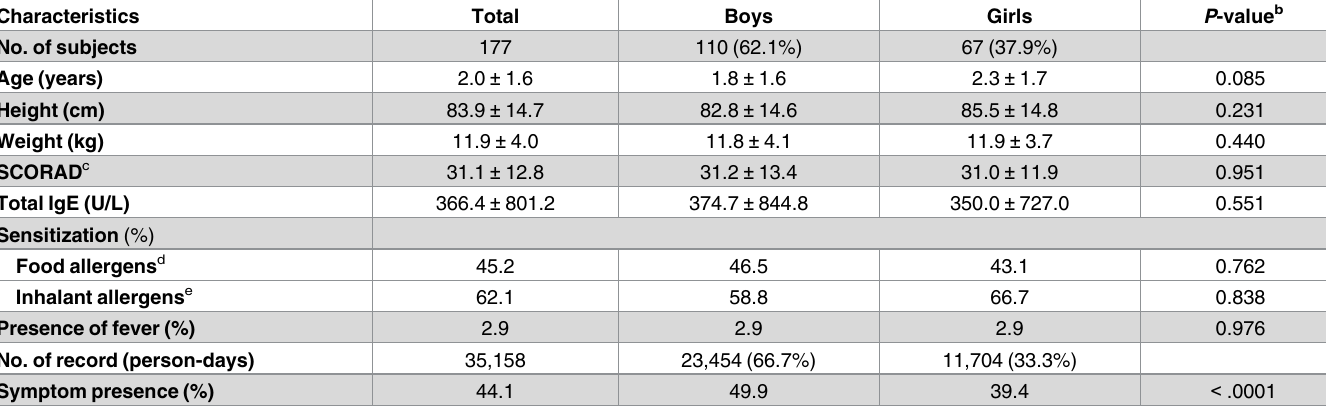
Table 1. Characteristics of the study subjects and summary of atopic dermatitis symptoms a .